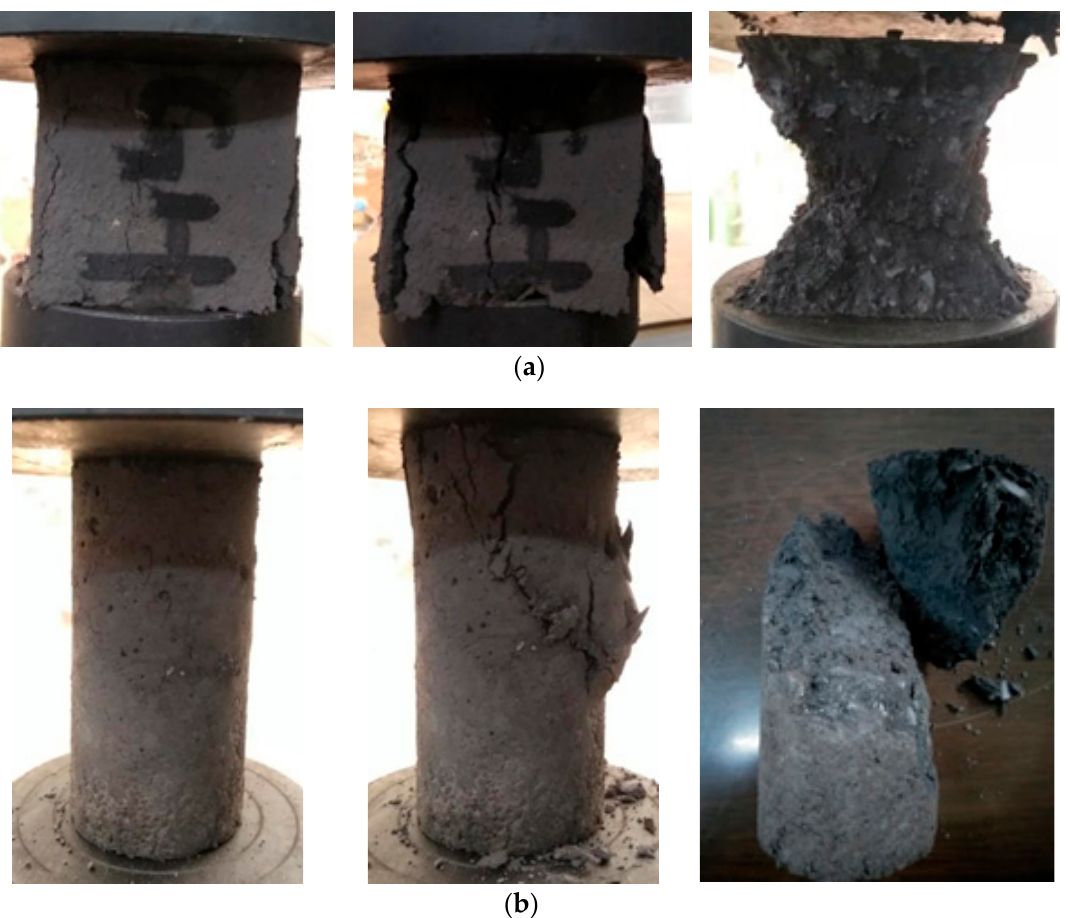
Figure 4. Failure mode of gangue paste material under uniaxial compression. ( a ) Failure mode of cube specimen under compression. ( b ) Failure mode of cylindrical specimen under compression.